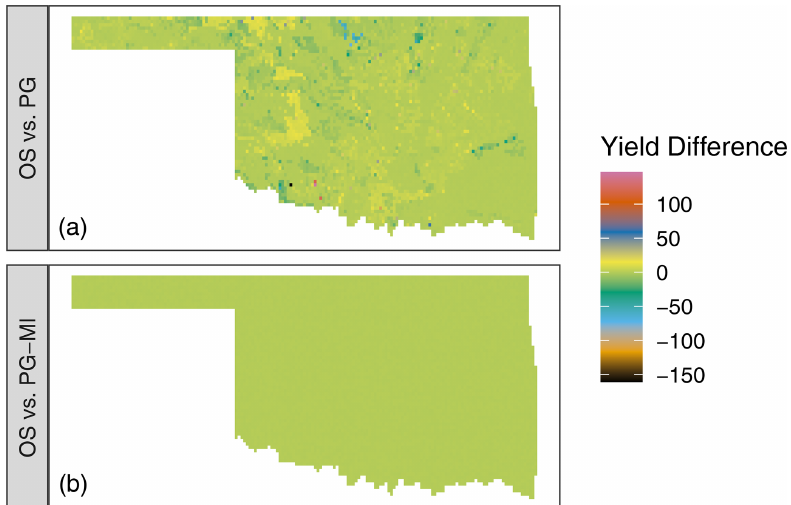
Figure 4. Difference in simulated winter wheat yield (kgha − 1 ) for the 2008–2009 growing season in Oklahoma, USA, when comparing the standard open-source version of DSSAT-CSM (OS) (a) to the parallel gridded version (PG) documented in this article or (b) to the PG version with additional code to mimic the rounding of soil input data as occurs in the OS version (PG-MI). Positive values indicate that OS simulated higher yield than PG or PG-MI, while negative values indicate that OS simulated lower values than PG or PG-MI.